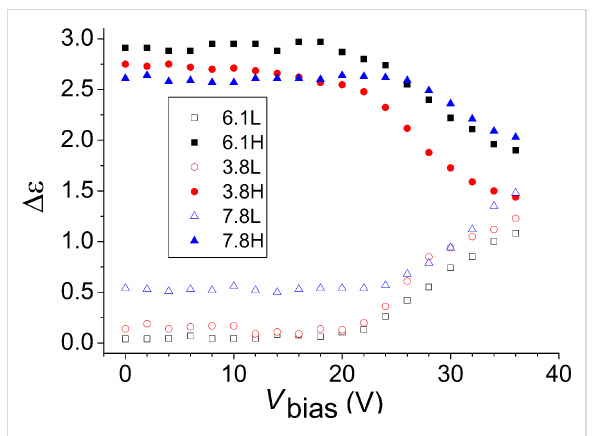
Figure 6: Dependence of the dielectric strengths ( Δε ) on the bias voltage for two processes (high frequency (H) and low frequency (L)) on the bias voltage in BCN66 (7.8 µm) and in BCN84 (3.8 µm and 6.1 µm) [51].